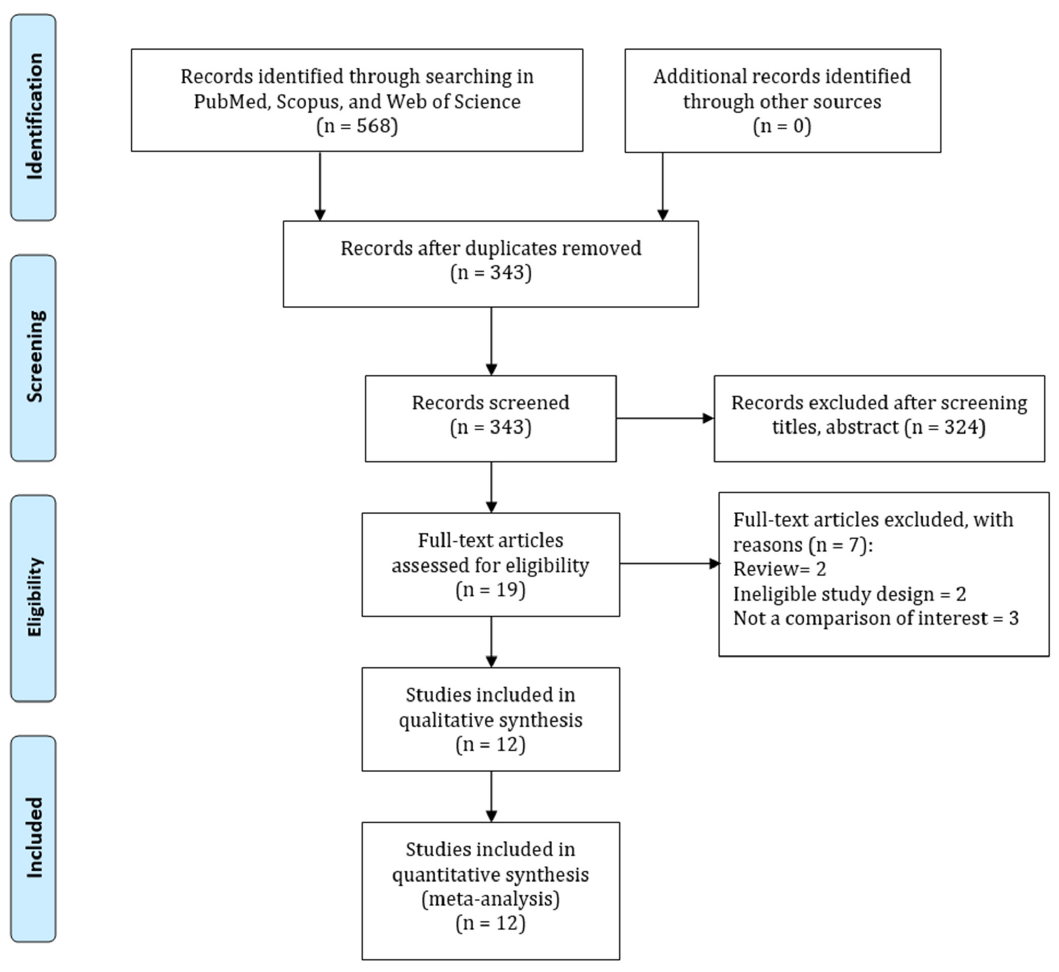
Figure 1. Flow chart of study selection process for the association between PPI use and acute kidney injury risk.